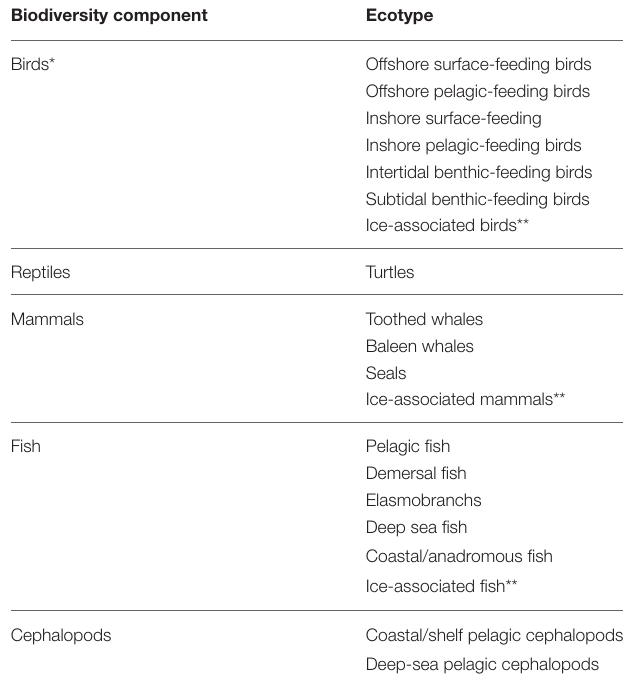
TABLE 2 | Predominant functional and/or feeding groups within the main biodiversity components for application in assessment of motile biodiversity